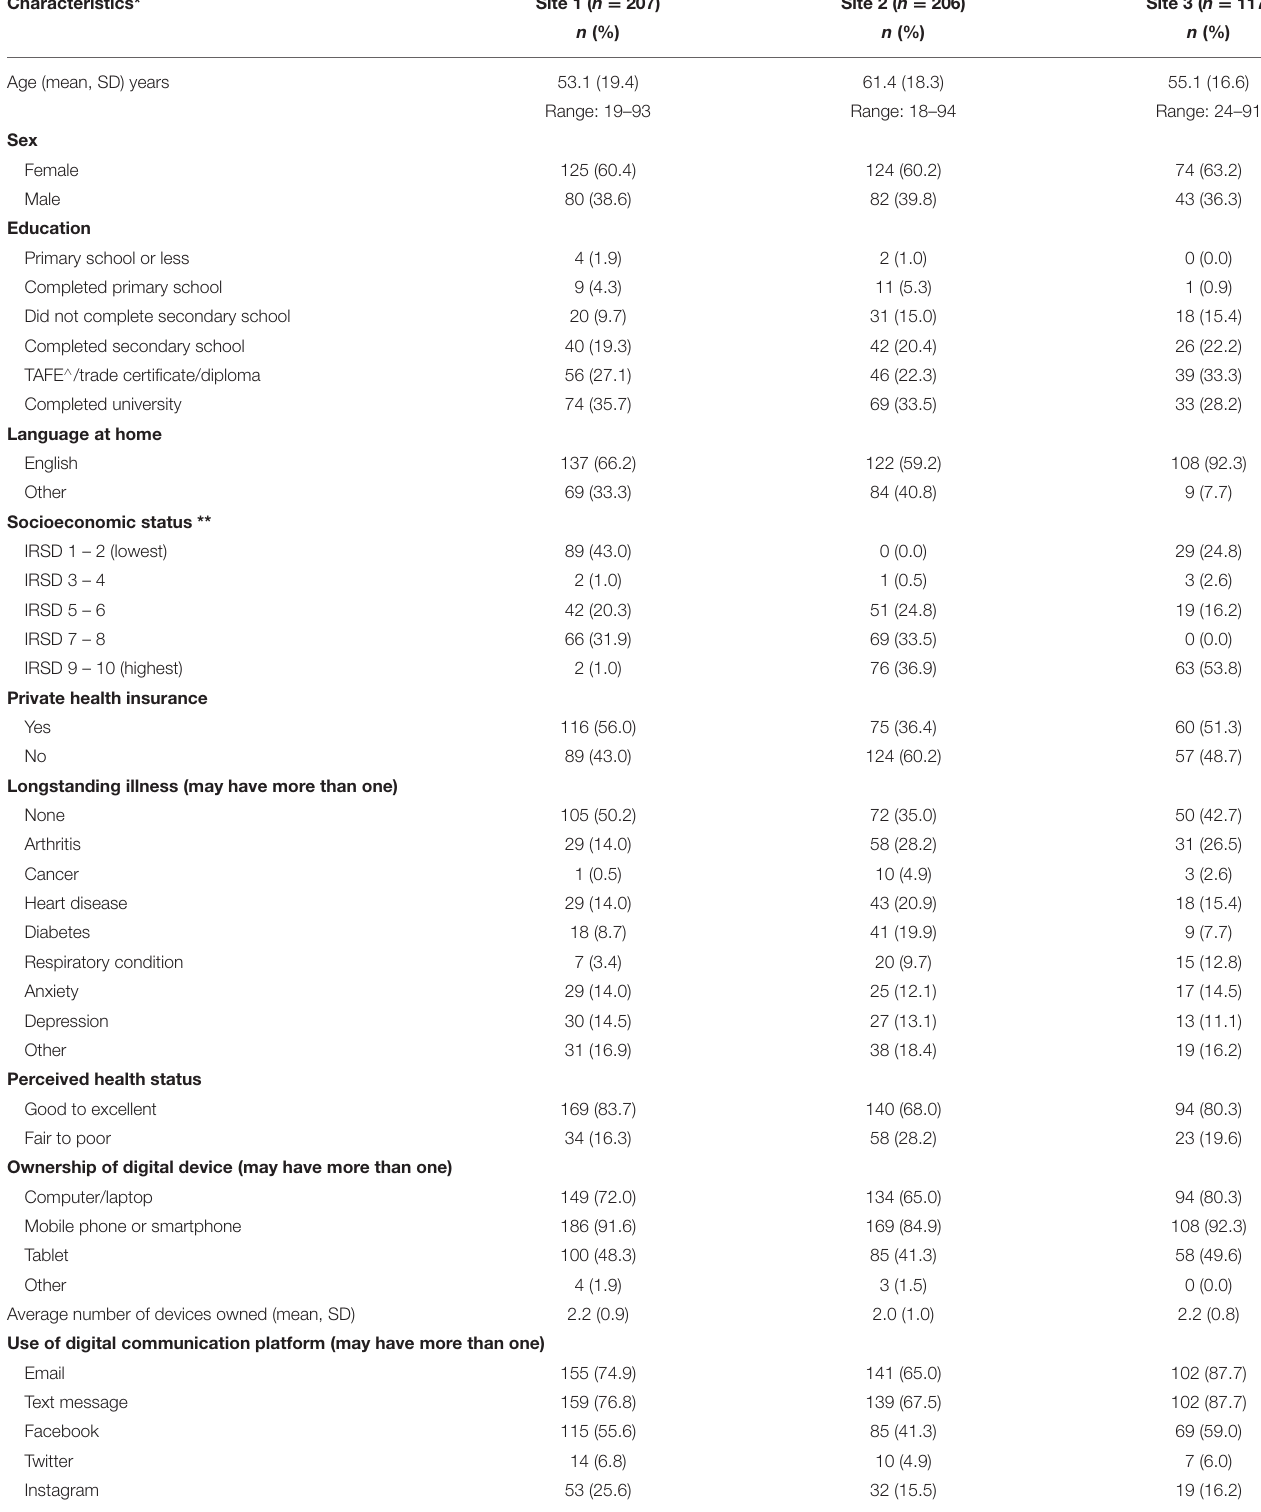
TABLE 2 | Sociodemographic characteristics of respondents of Site 1 (metropolitan primary care medical practice), Site 2 (metropolitan community health), and Site 3 (regional primary care medical practice).